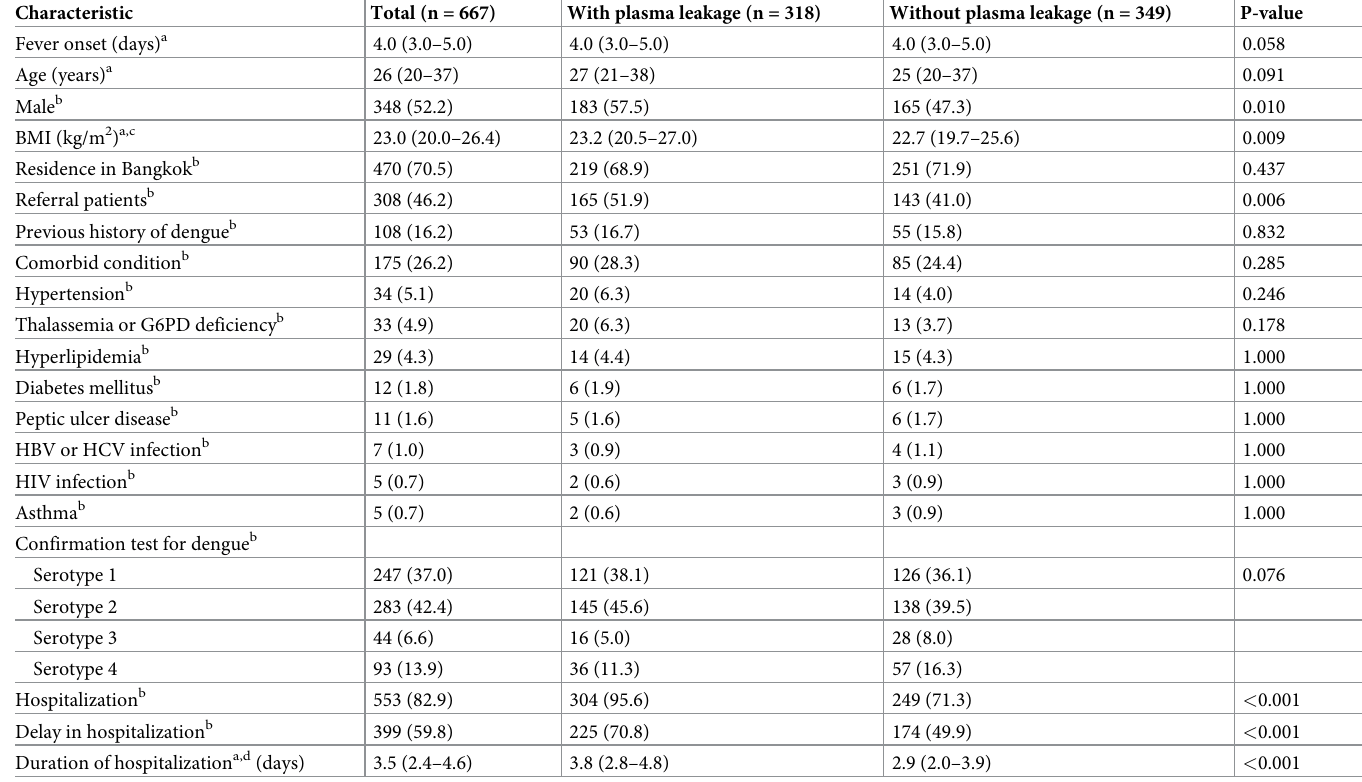
Table 1. Patients’ characteristics, dengue serotypes, and outcomes of plasma leakage status (n = 667).